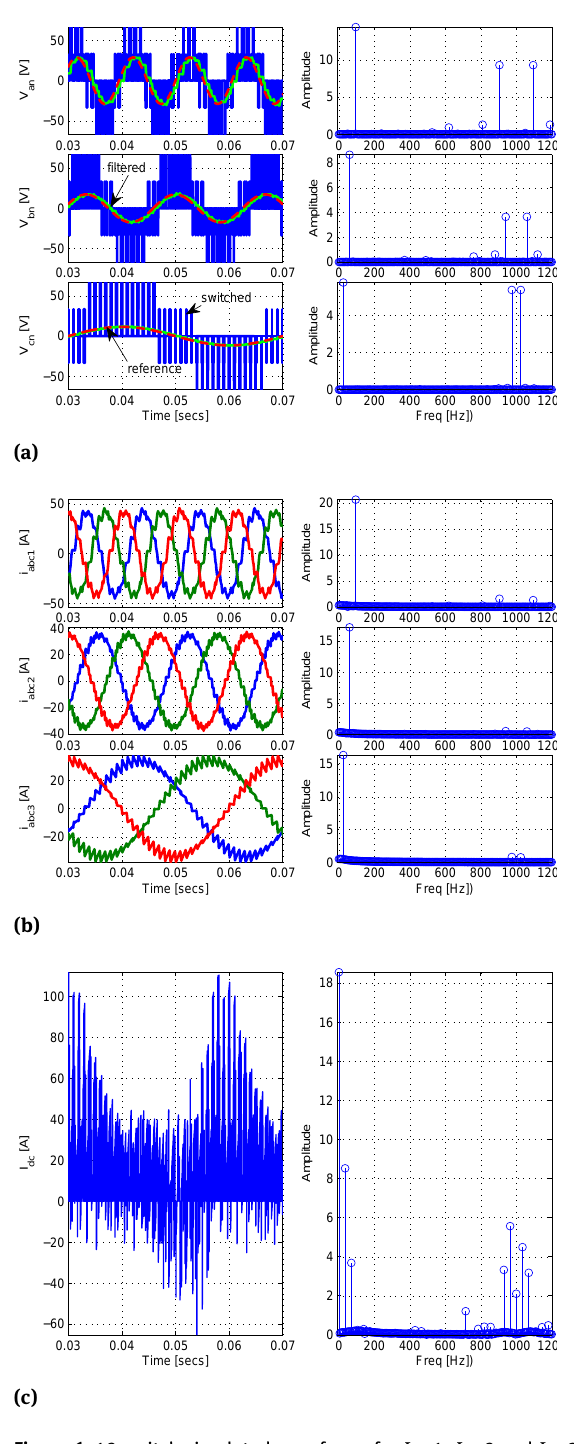
Figure 6: 12 -switch simulated waveforms for Inv 1 , Inv 2 and Inv 3 : (a) phase a voltages ( Inv 1 : top, Inv 2 : middle, and Inv 3 : bottom), (b) phase currents ( Inv 1 : top, Inv 2 :middle, and Inv 3 : bottom), and (c) input DC current and its harmonic spectrum.